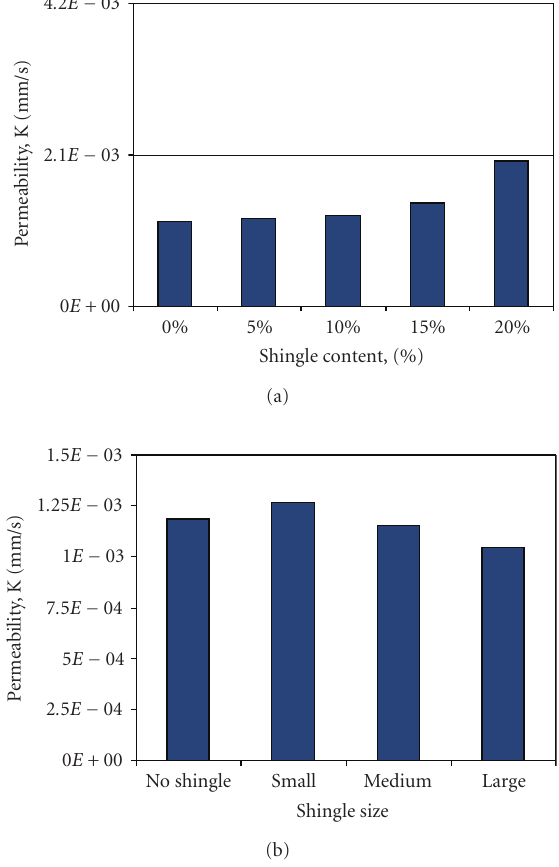
Figure 7: Permeability for di ff erent shingle sizes: (a) small shingle size and (b) 10%